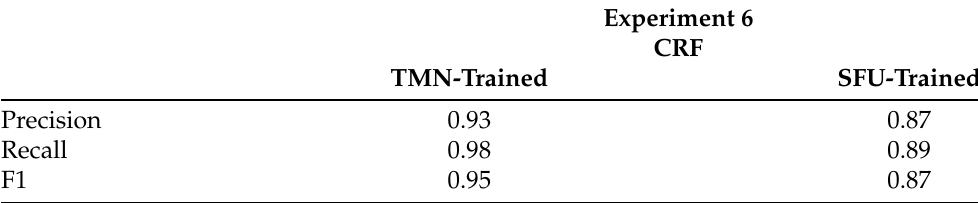
Table 8. Results for negation cue detection testing on the T-MexNeg